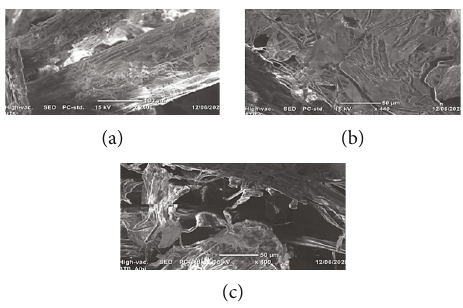
Figure 4: The SEM micrographs of (a) UTS, (b) ATB, and (c)